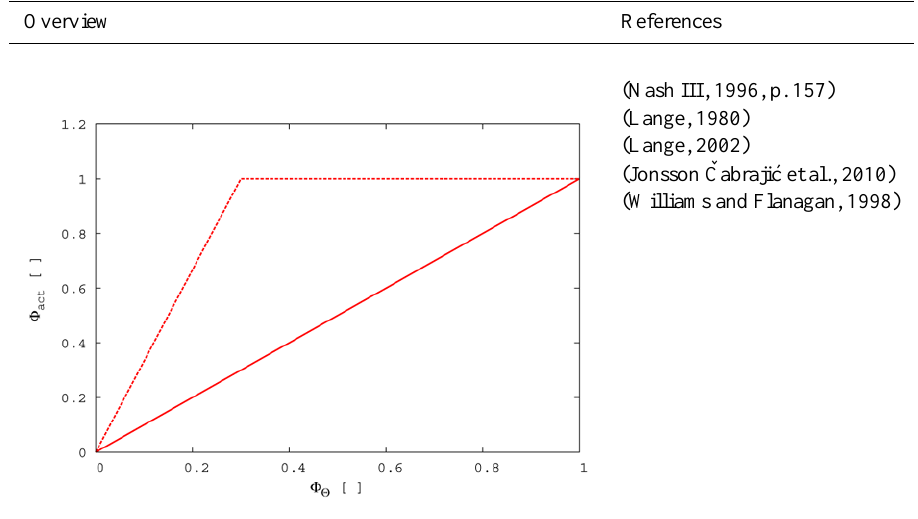
Fig. B11. Metabolic activity 8 act as a function of water saturation 8 2 . The dashed line corresponds to x 8 = 1 . 0 corresponds to x 8 2, sat